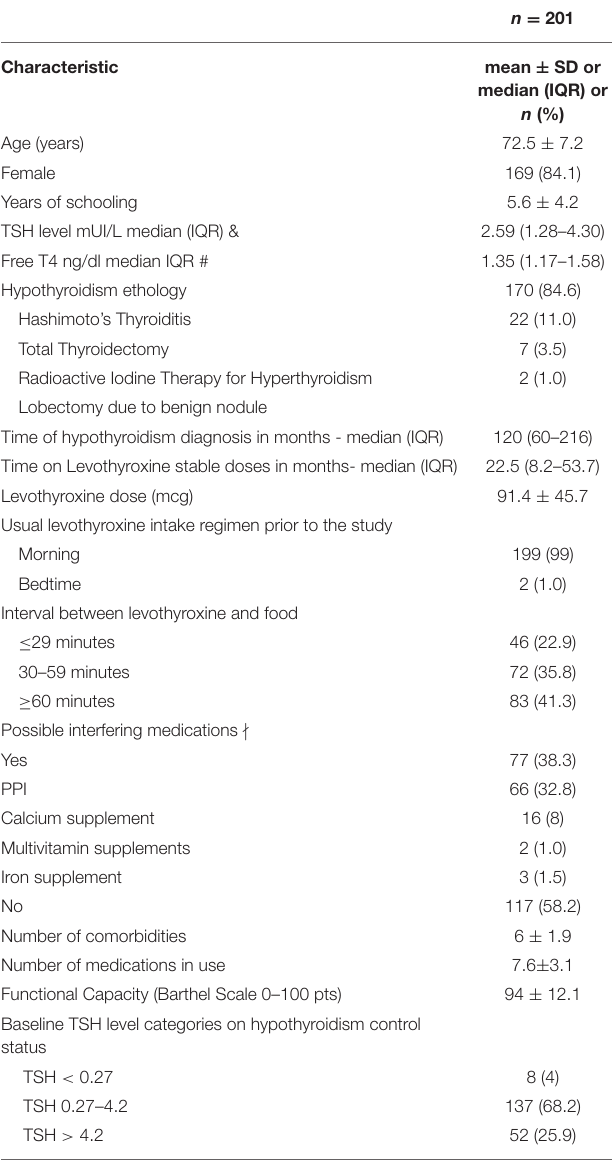
TABLE 1 | Baseline characteristics of the 201 enrolled